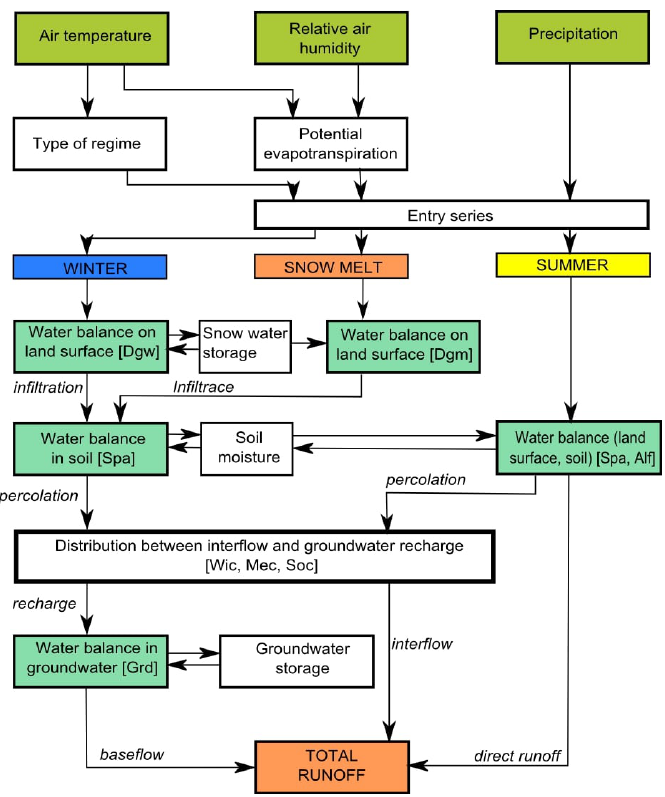
Figure 2. The Bilan hydrological